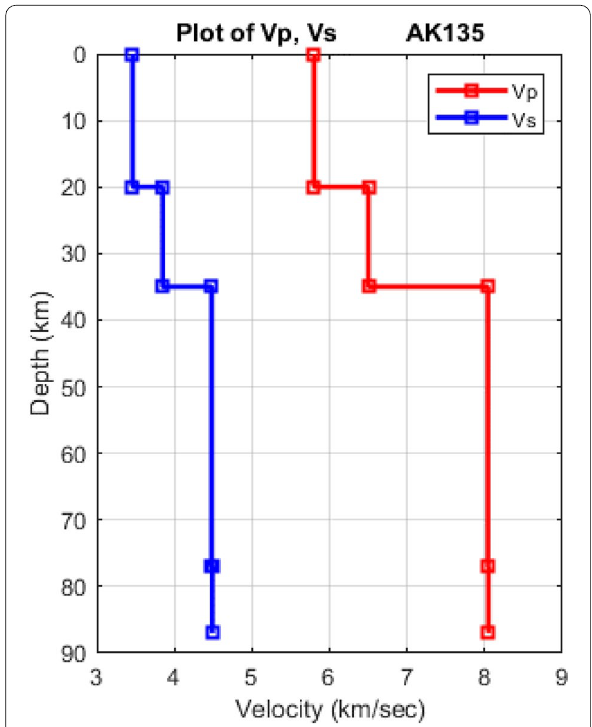
Fig. 3 The AK135 velocity model which is applied for the calculation of the Green’s functions in this study and adopted from Kennett et